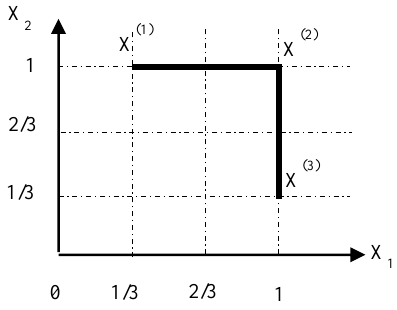
Figure 1. Illustration of trajectory in input space when k =